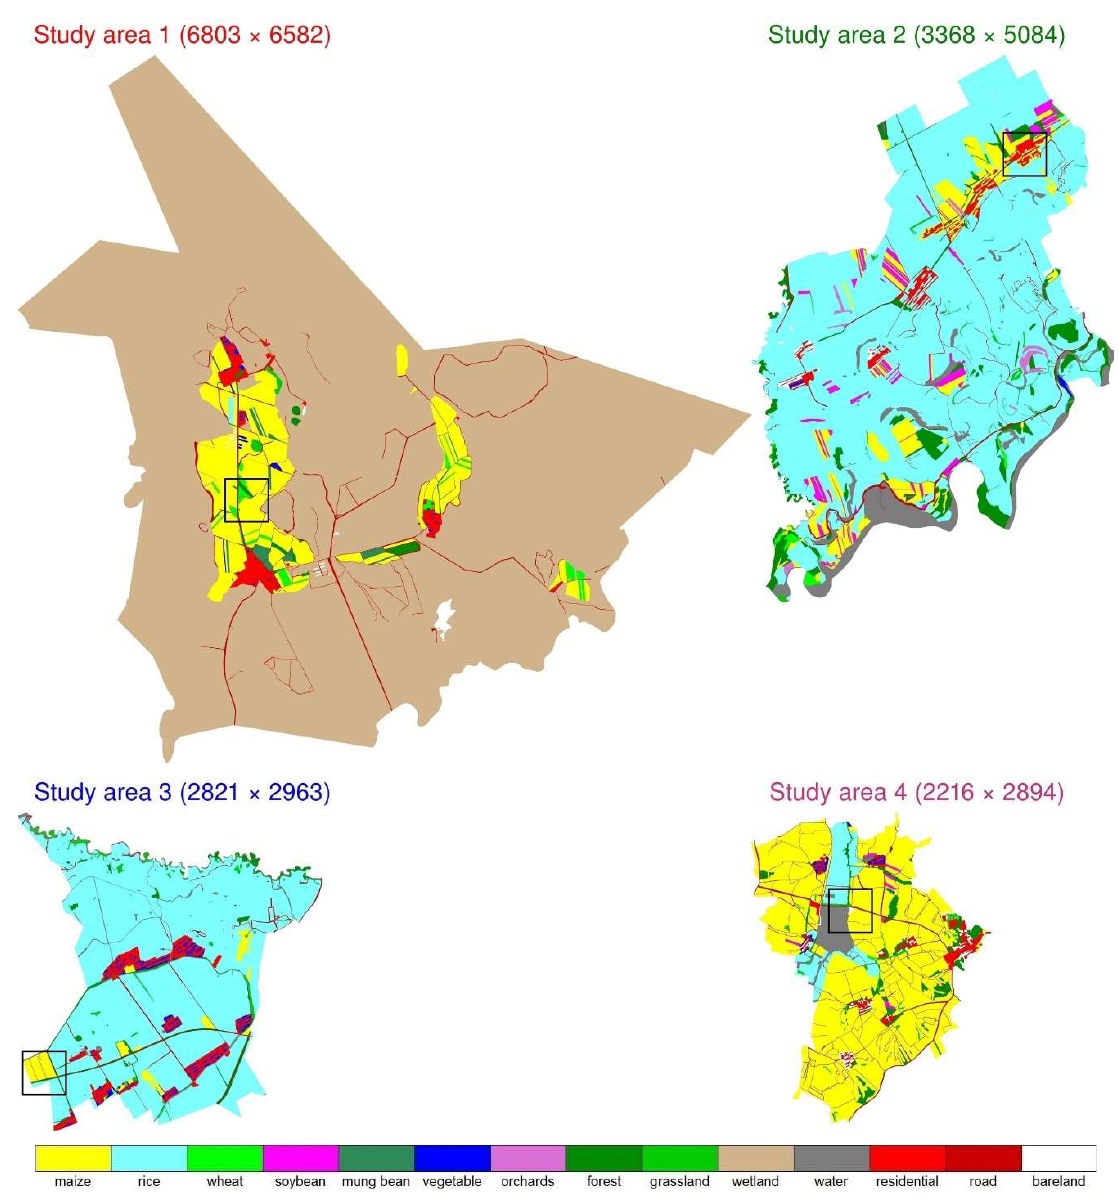
Figure 3. Four study area reference land cover maps (see Figure 2 caption for detailed information).